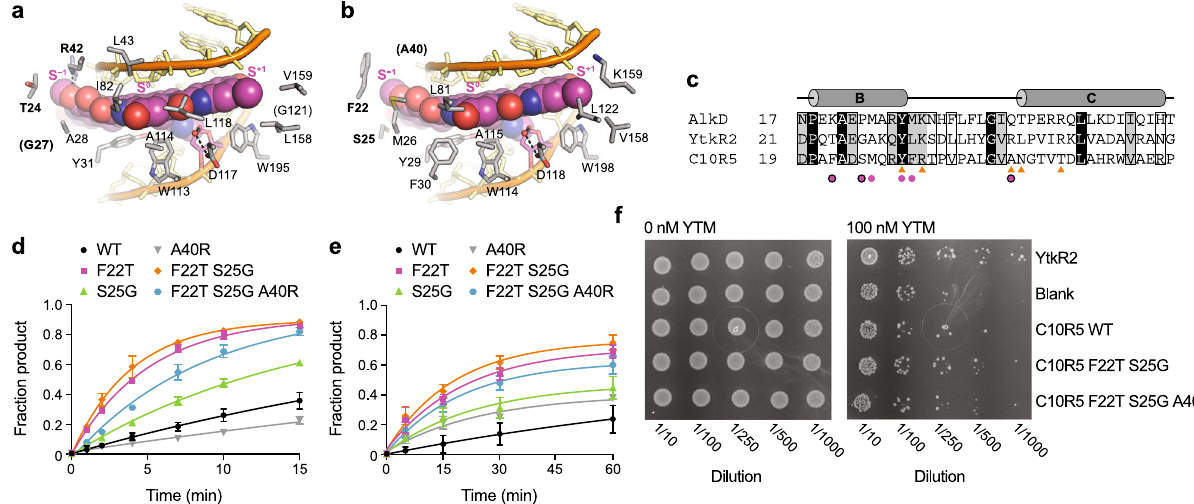
Fig. 6 Molecular basis of C10R5 substrate speci fi city. a , b Close-up views of YtkR2 ( a ) and C10R5 ( b ) homology models bound to AP-DNA and YTM- Ade. Hydrogen-bonding interactions are indicated with dashed lines. c Truncated sequence alignment of AlkD, YtkR2, and C10R5. Residues that interact with AP-DNA and YTM-Ade in the AlkD product complex (PDB accession 5UUG) are indicated with orange triangles and magenta circles, respectively. d Single-turnover excision of YTM-Ade by wild-type and mutant C10R5. Reactions contained 1 μ M enzyme and 100 nM DNA. e Multiple-turnover excision of YTM-Ade by wild-type and mutant C10R5. Reactions contained 10 nM enzyme and 100 nM DNA. Mutated residues are indicated with bold font in a and b and with black circles in c . Data in d and e are presented as the mean ± SD from three replicate experiments. Source data are provided as a Source Data fi le. f YTM resistance conferred by C10R5 mutants. E. coli BL21(DE3) cells were transformed with either an empty plasmid (blank) or a plasmid encoding YtkR2, C10R5, or one of two C10R5 mutants, and grown in the absence or presence of YTM. Experiments were performed in